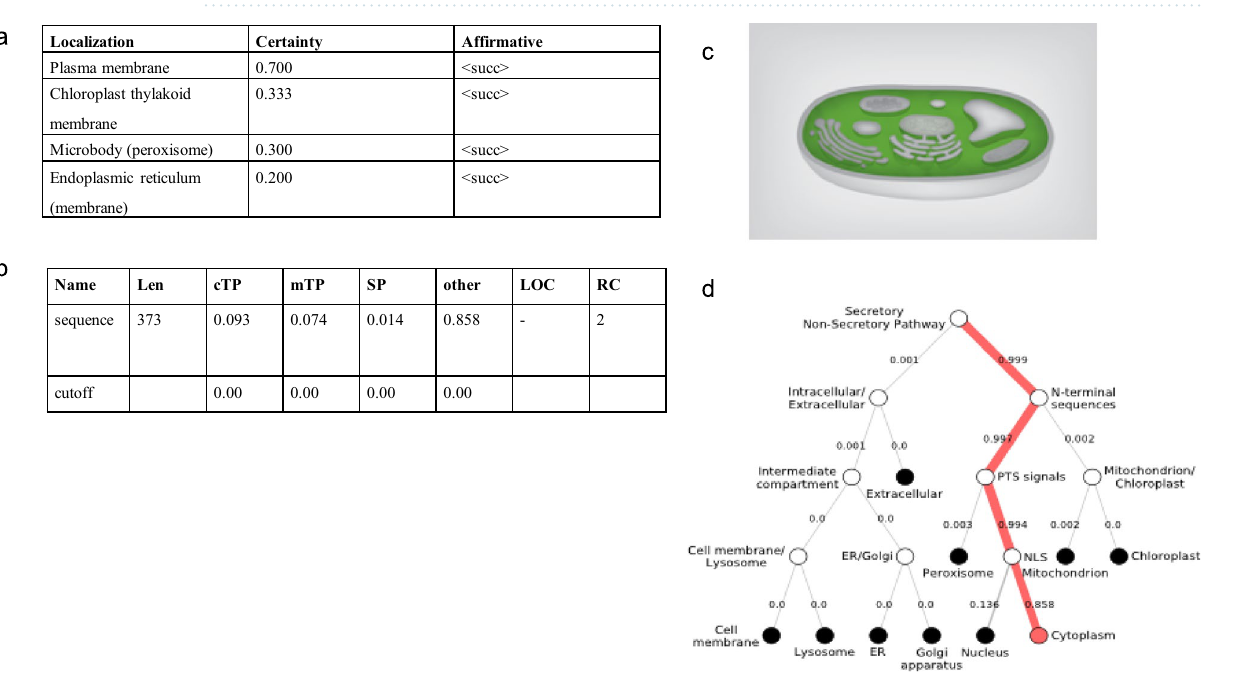
Figure 4. The predicted protein subcellular location results ( a ) by using Psort, ( b ) TargetP; mitochondrial targeting peptide, SP, cTP; chloroplast transit peptide, mTP; secretory pathway, ( c ) LocTree3, ( d )